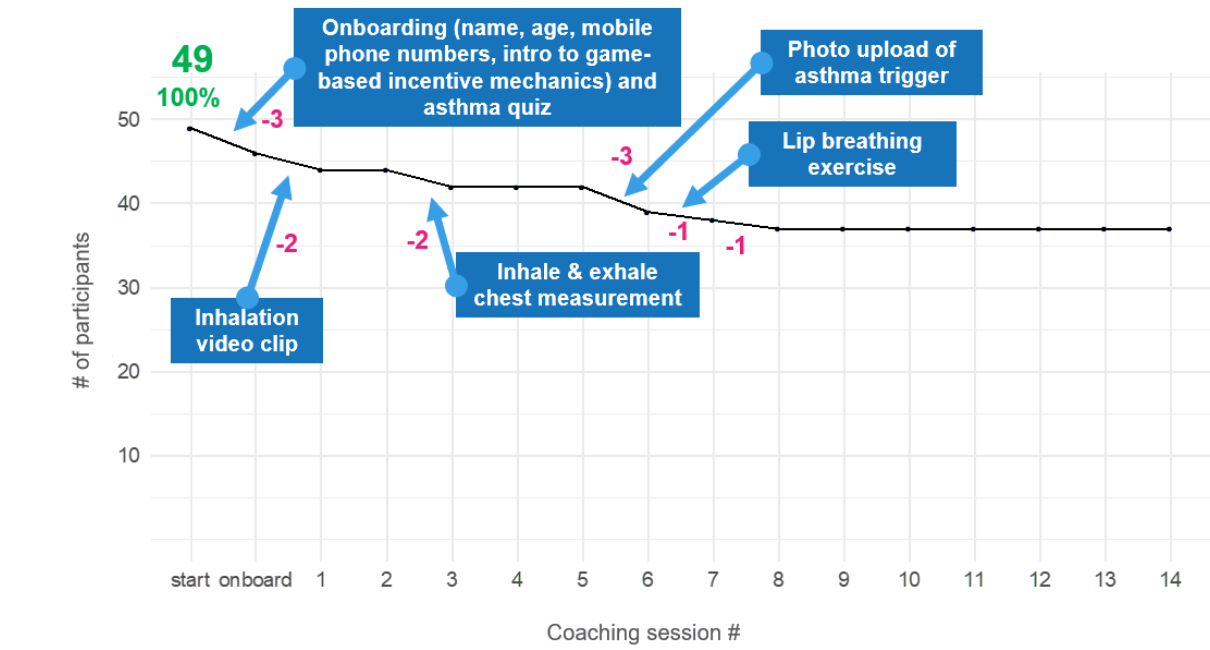
Figure 5. Participants for each coaching session and potential reasons for